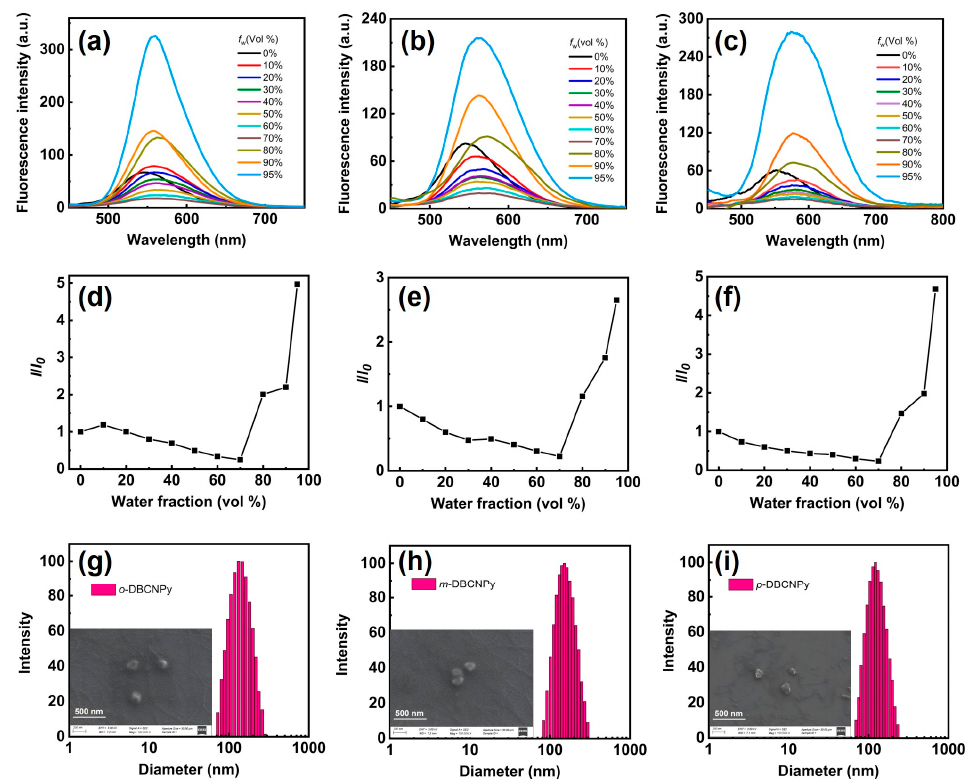
Figure 4. Fluorescence spectra, variation in relative emission intensity ( I / I 0 ), and emission maxima wavelength of o -DBCNPy ( a , d ), m -DBCNPy ( b , e ), and p -DBCNPy ( c , f ) in THF–water mixtures with increasing f w (concentration of compound: 1 × 10 − 5 M, λ ex = 415 nm); size distributions of o -DBCNPy ( g ), m -DBCNPy ( h ), and p -DBCNPy ( i ) aggregates in THF–water mixtures ( f w = 95%) (insets are SEM images of the particles).